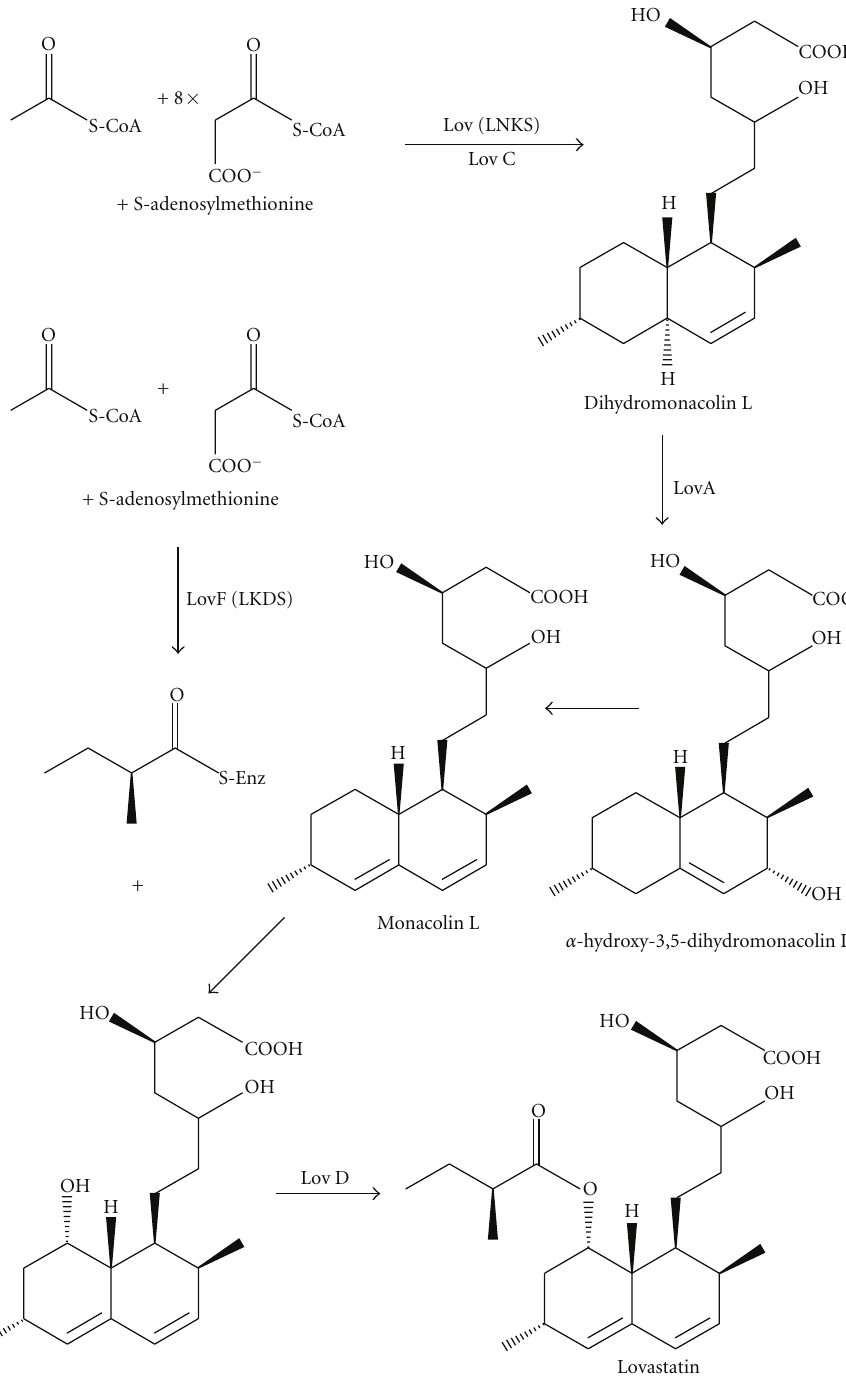
Figure 2: Lovastatin production pathway